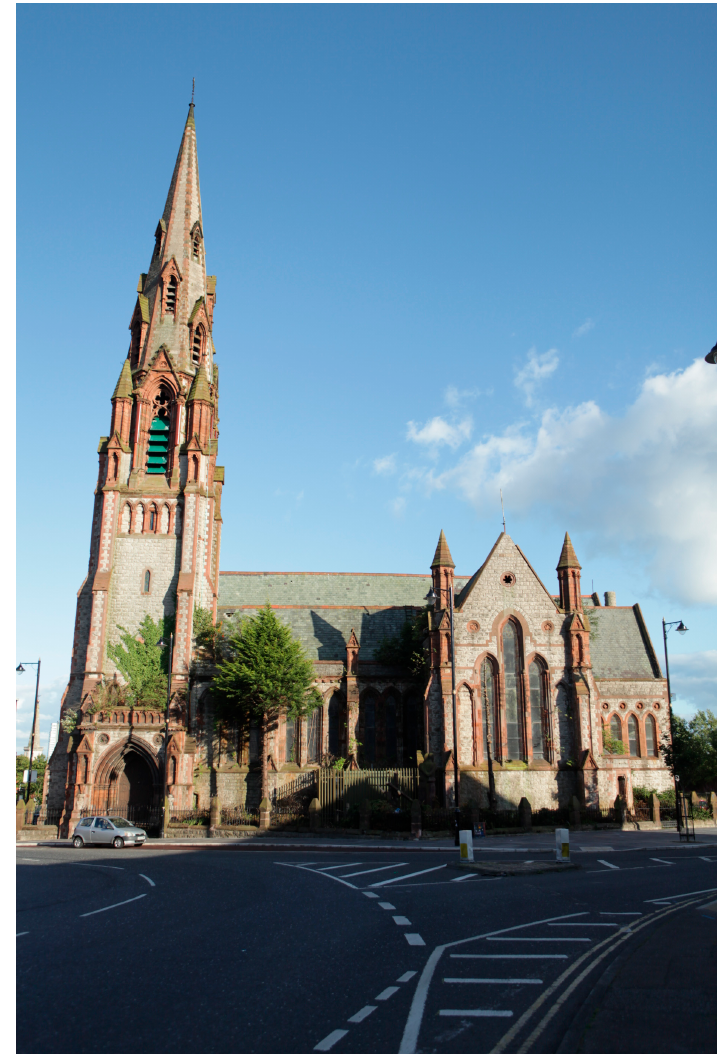
Figure 1. Carlisle Memorial Methodist Church.